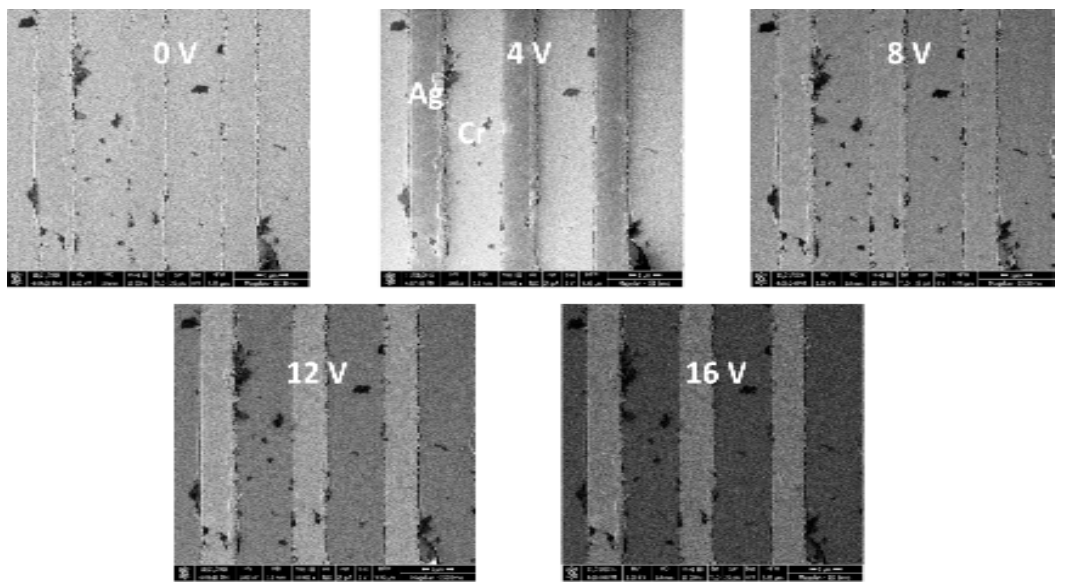
Figure 10. Ag (1 µ m) / Cr (2 µ m) stripes on a silicon substrate, the potential on the sample are 0, 4, 8, 12, and 16 V.